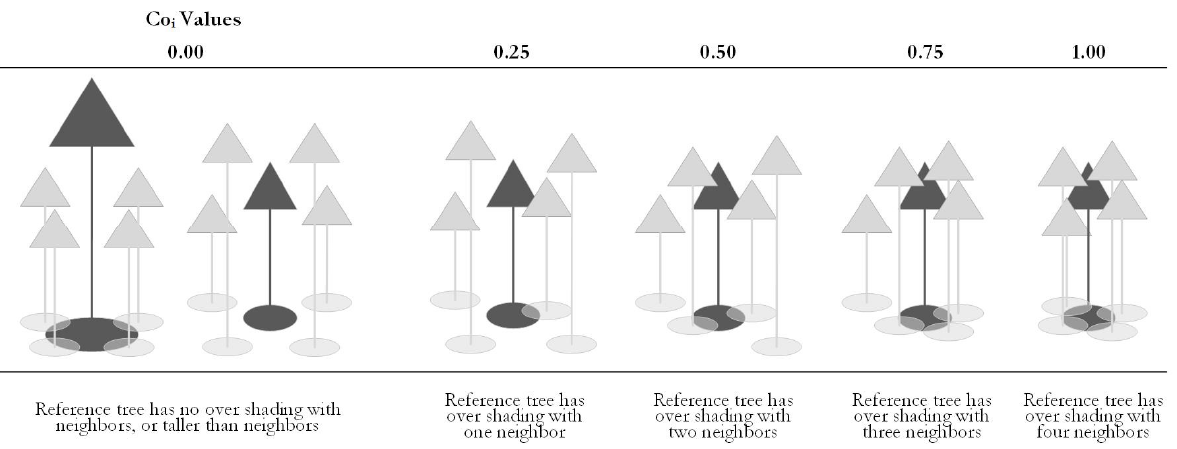
Figure 6. Principle of the competition degree.